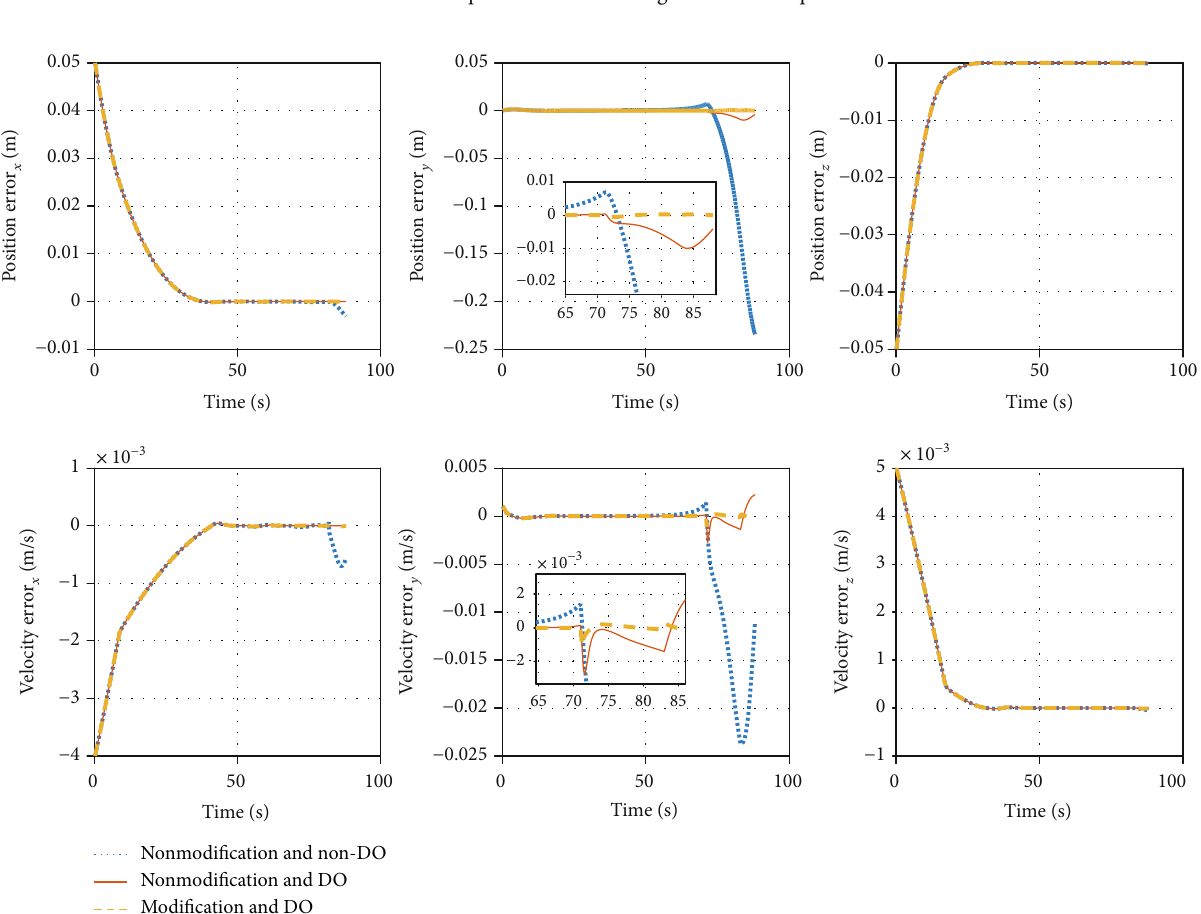
Figure 14: Comparisons of the trajectory tracking